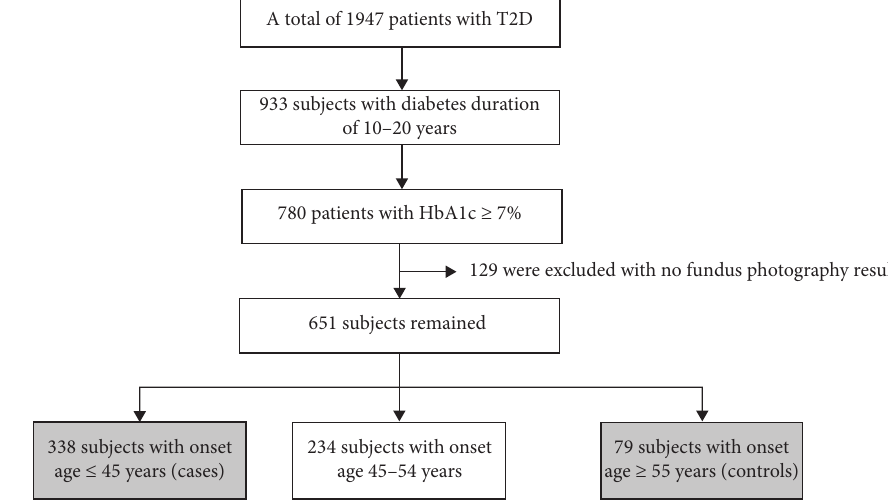
Figure 1: Flow chart of the Table 1: Demographic and clinical characteristics of type 2 diabetes patients.